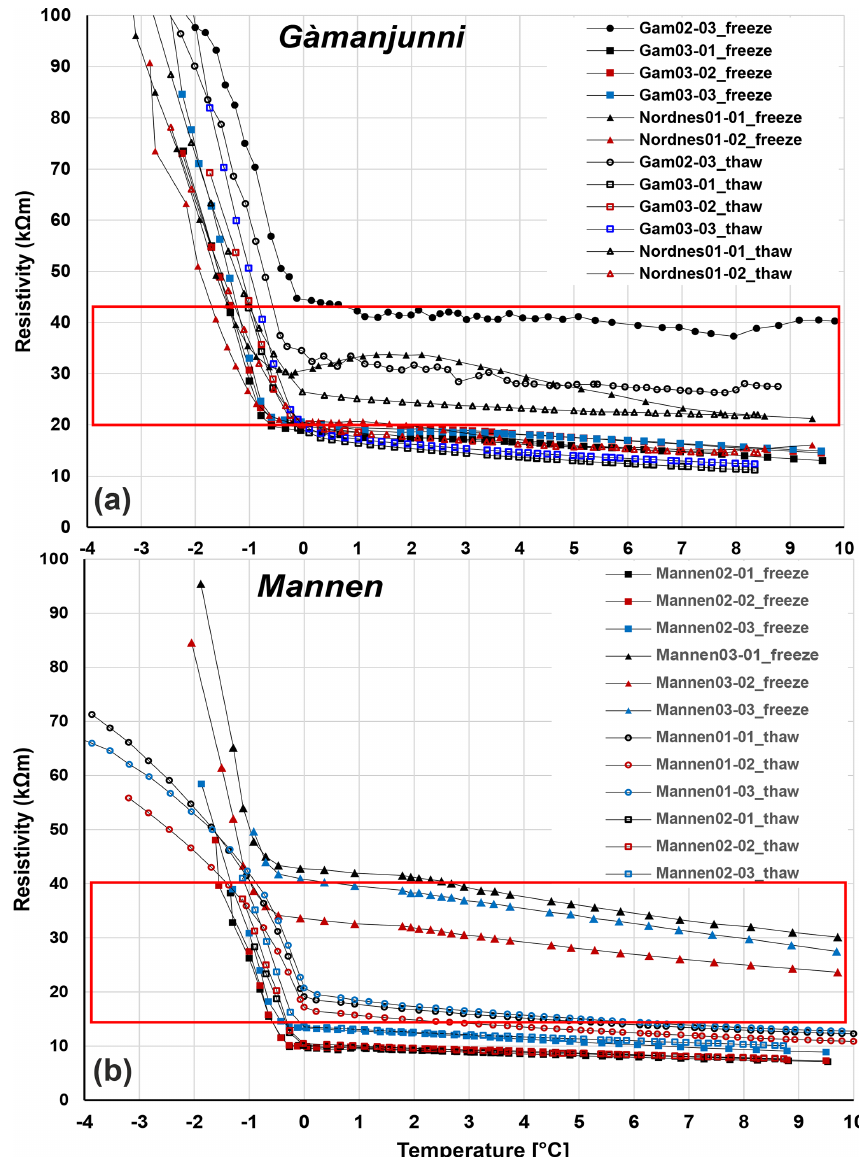
Figure 3. Temperature–resistivity plots of all successful test series for rock samples from (a) Gámanjunni-3 and Nordnes as well as (b) the Mannen plateau. The red rectangles denote the transition zone between frozen and unfrozen conditions defined based on these laboratory tests. These calibrations are used for plotting in Figs. 8, 9, 10, 12, B1 and